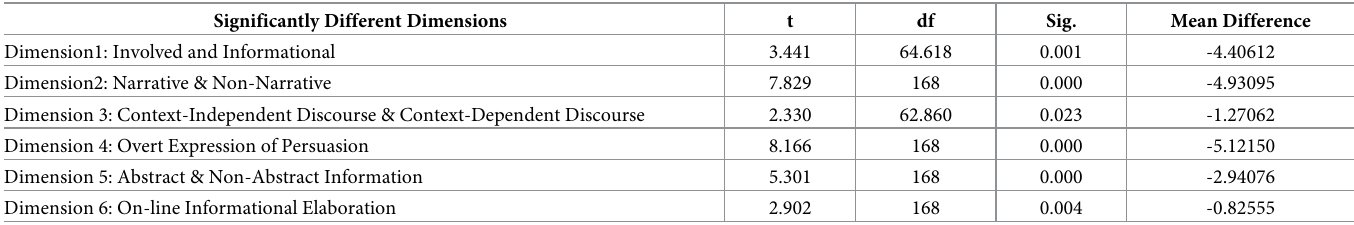
Table 2. T-test for dimensional differences between CAQF and Crown &